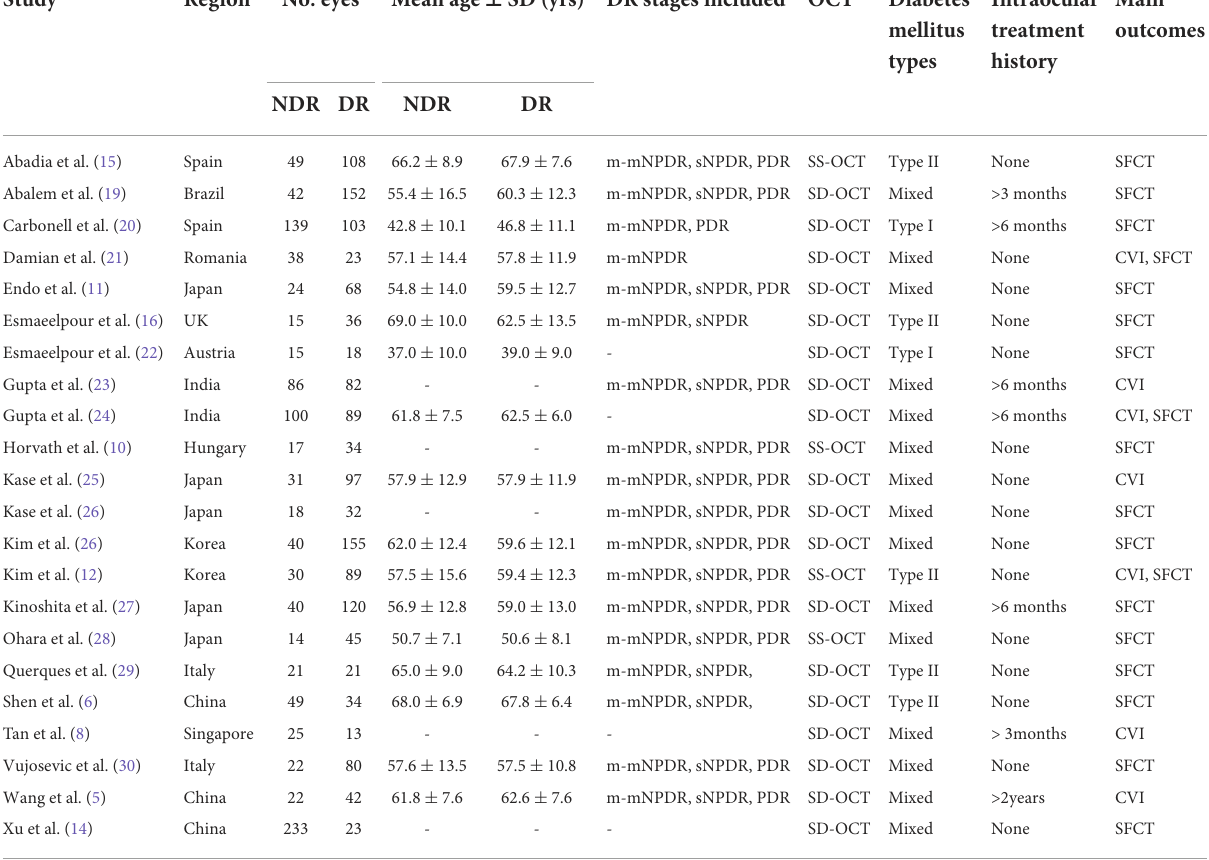
TABLE 1 Characteristics of included